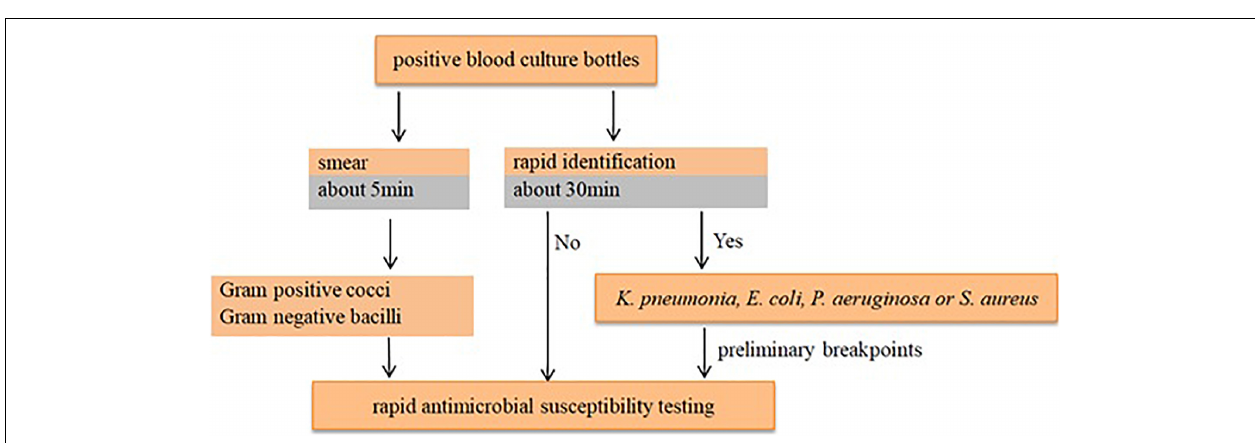
FIGURE 2 | The protocol of rapid processing of positive blood culture in our